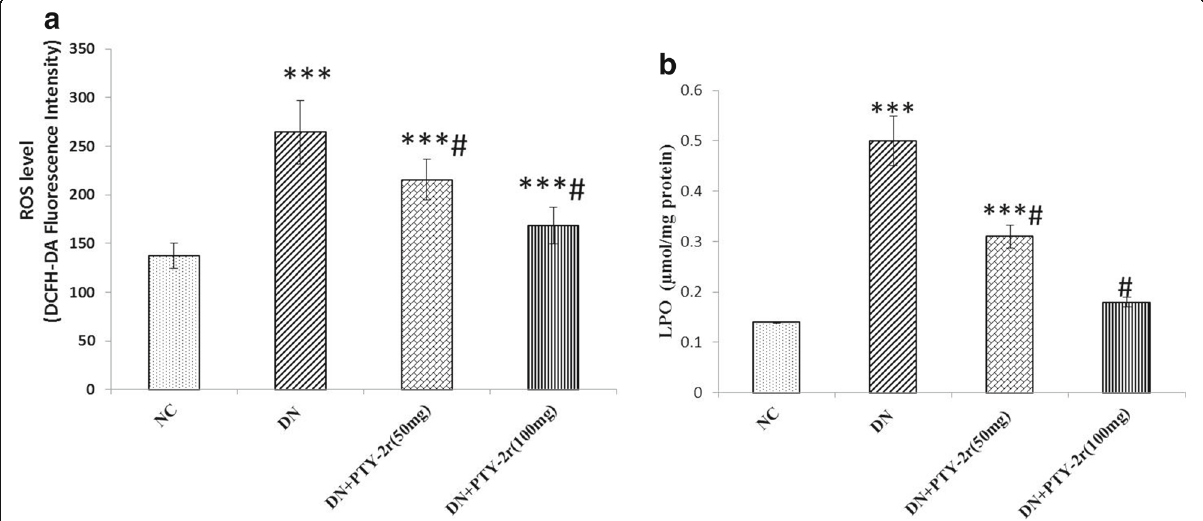
Fig. 2 Effects of PTY-2r on Overproduction of Free Radicals: ( a ) ROS measured by DCFH-DA fluorescence intensity ( b ) Concentration of LPO in the kidney of NC, DN control, DN + PTY-2r (50 mg/100 g) and DN + PTY-2r (100 mg/100 g). Data are presented in mean ± SD ( n = 6 in each group). *** p < 0.001, compared with group-1, # p < 0.001 compared with